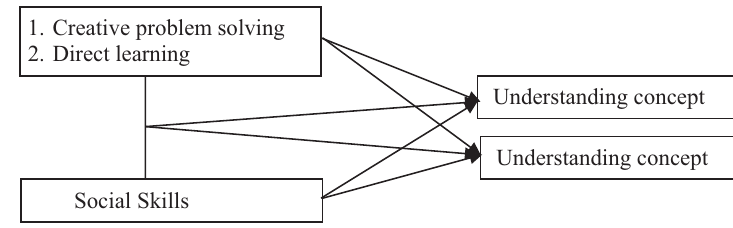
Figure 1. Research design (source: created by